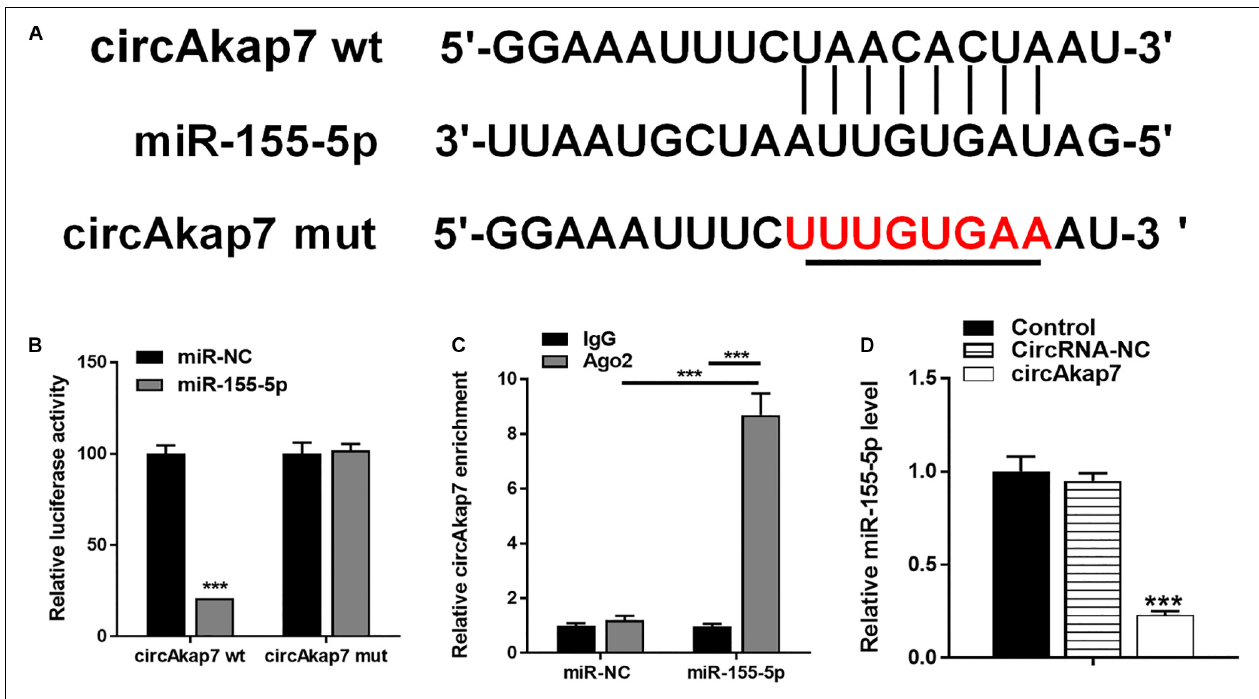
FIGURE 6 | circAkap7 functions as a miRNA sponge to negatively regulate miR-155-5p. (A) Wt or mut circAkap7 transfected into astrocytes with or without synthetic miR-155-5p mimics. (B) Relative luciferase activity as detected by luciferase assay in astrocytes. (C) Anti-Ago2 RIP was performed in